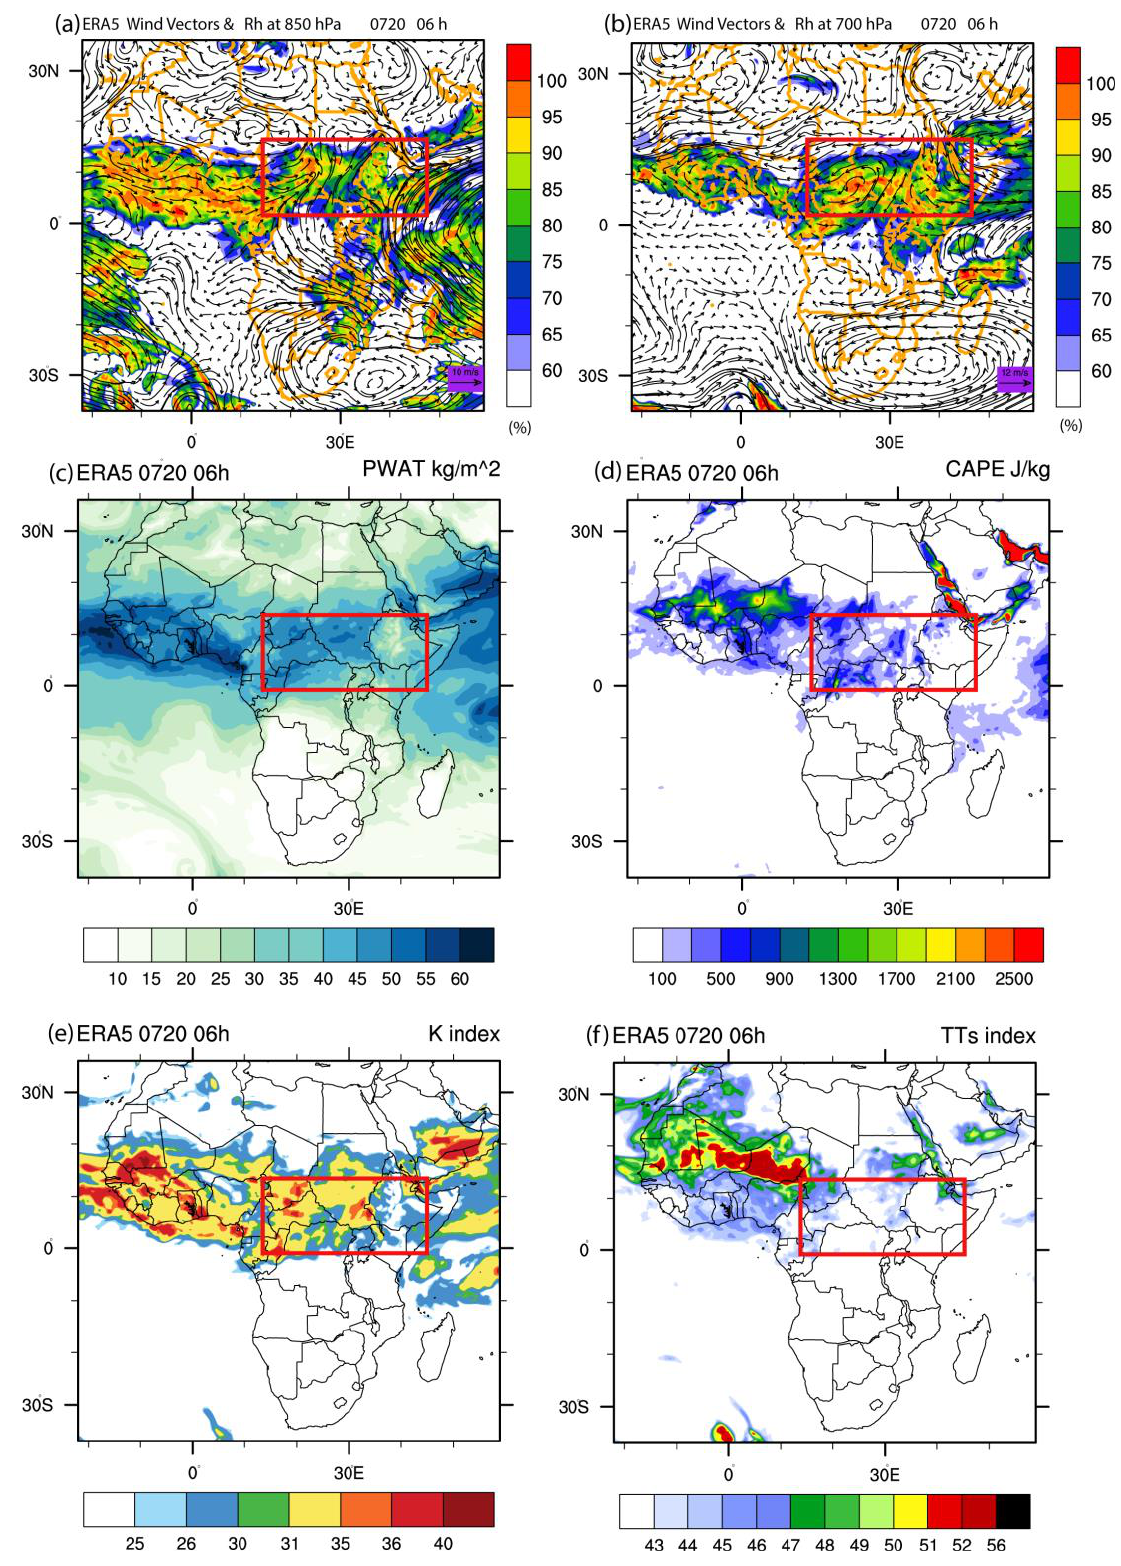
Figure 14. Synoptic analysis of ERA5 data at 6am (UTC) on 20 June 2020. ( a ) wind at 10 m (m/s; vectors) and relative humidity (%; shaded) at 850 hPa; ( b ) wind (m/s; vectors) and relative humidity (%, shaded) at 700 hPa; ( c ) precipitable water (kg/m 2 ); ( d ) convective available potential energy (J/kg); ( e ) K-index; and ( f ) total of totals index. The red box denotes the ROI (South Sudan–Ethiopia